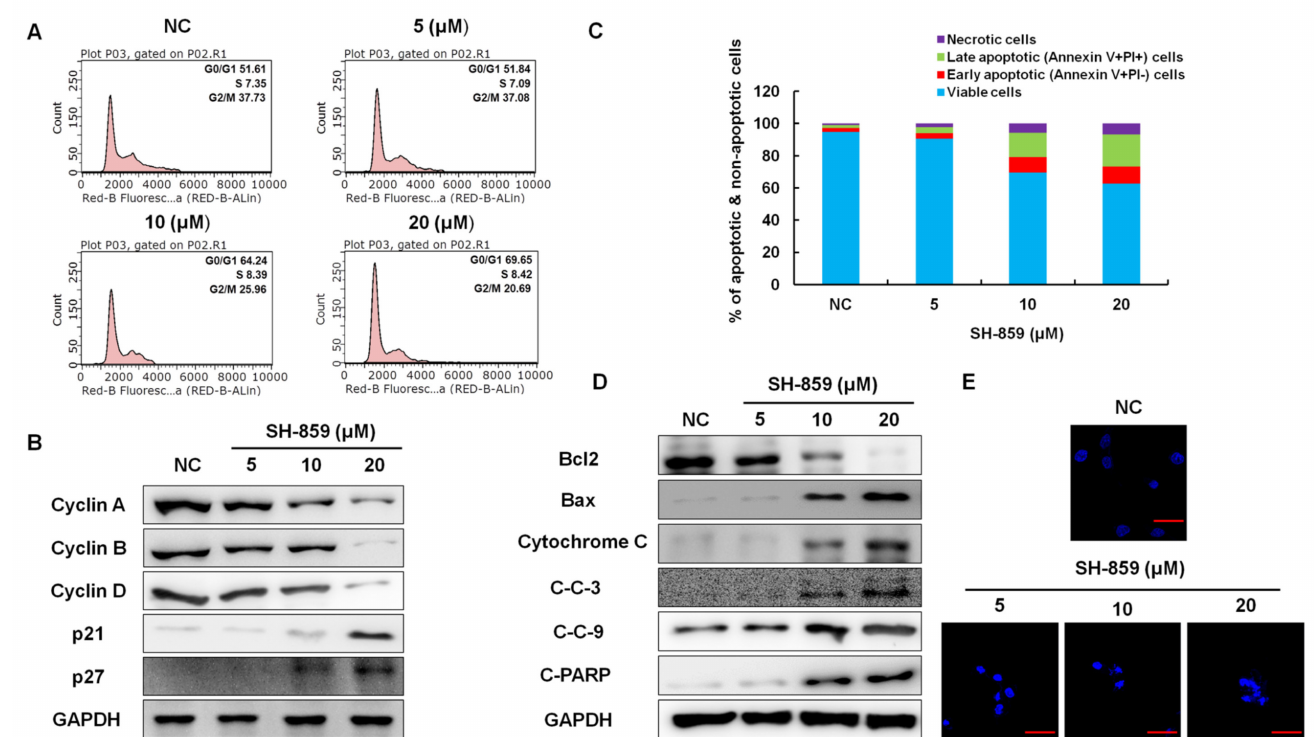
Figure 2. E ff ect of SH-859 on cell cycle and apoptosis regulation in 786-O cells. The cells were grown to log phase and treated with the specified concentrations of SH-859 (5, 10, and 20 µ M) for 48 h. ( A ) To evaluate cell distribution at each phase of the cell cycle, we stained all the cells with propidium iodide and investigated them by flow cytometry. ( B ) E ff ect of SH-859 on the expression levels of di ff erent cell cycle regulatory proteins. The cells were harvested, and cell lysates were examined by Western blotting using antibodies specific for cyclin A, B, and D; P21; and P27. Glyceraldehyde 3-phosphate dehydrogenase (GAPDH) was used as an internal loading control. ( C ) The percentage of apoptotic cells was graphically represented after analysis by flow cytometry. ( D ) E ff ect of SH-859 on the expression levels of apoptosis regulatory proteins. The cells were harvested, and cell lysates were examined by Western blotting using antibodies specific for Bcl2, Bax, cytochrome c, cleaved caspase 3, cleaved caspase 9, and cleaved Poly (ADP-ribose) polymerase (PARP). GAPDH was used as an internal loading control. ( E ) Cells were stained with 4,6-diamidino-2-phenylindole dihydrochloride (DAPI) after SH-859 treatment. Images were observed using confocal microscopy (400 × ). Scale bars indicate 10 µ m. Representative results of three independent experiments ( n = 3) have been shown. NC: normal control (untreated 786-O